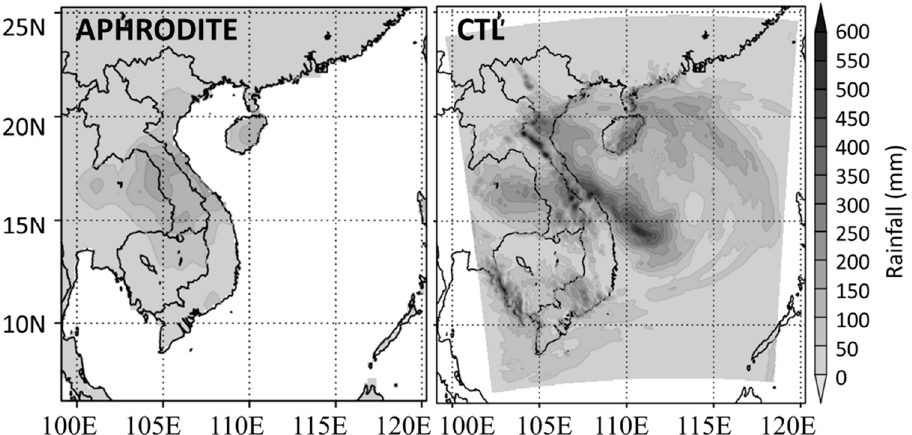
Figure 6. Spatial distribution of heavy rain from 01 to 03 October, 2007 of Asian Precipitation—Highly-Resolved Observational Data Integration towards Evaluation (APHRODITE) data and a simulation of nineteen ensemble members.